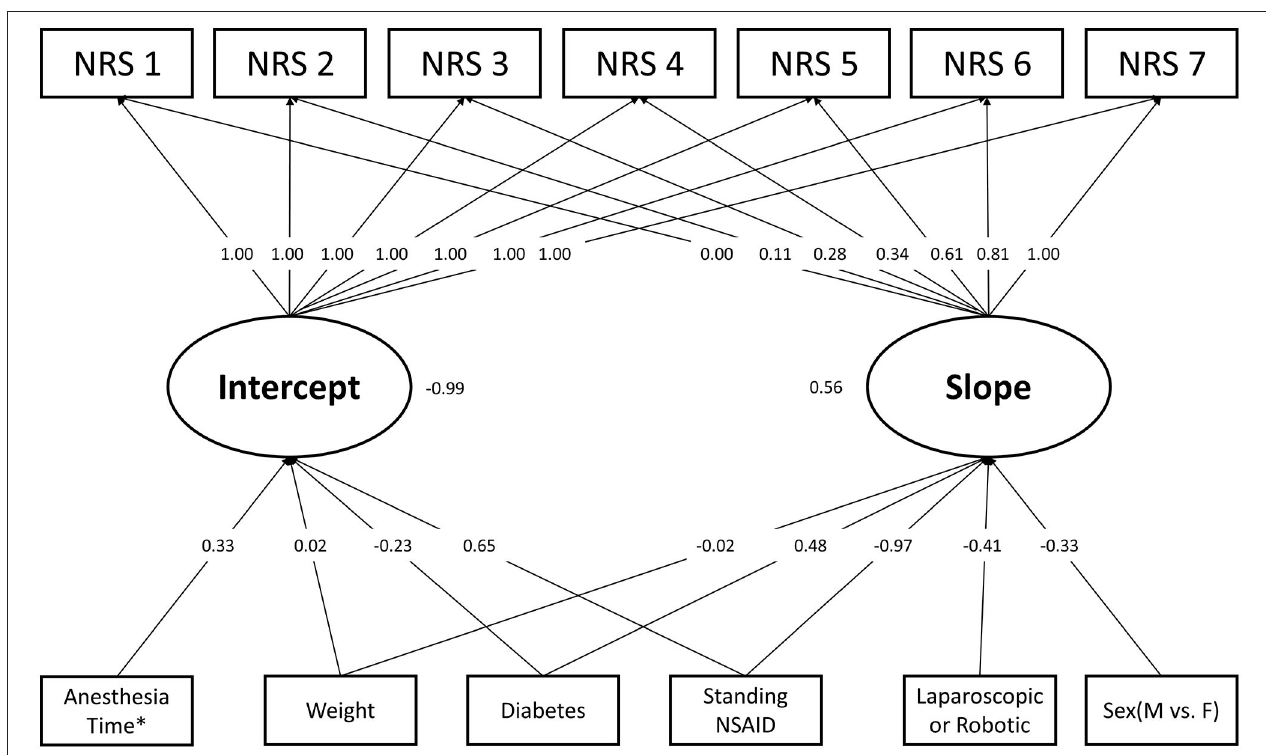
FIGURE 2 | Final multiple predictors latent curve model. *Log2 transformed.